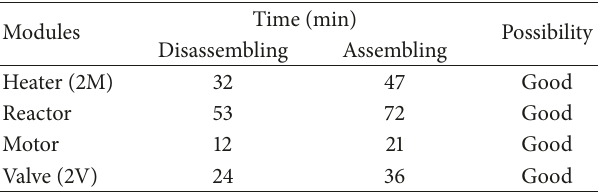
Table 3: Assembling and disassembling time of various